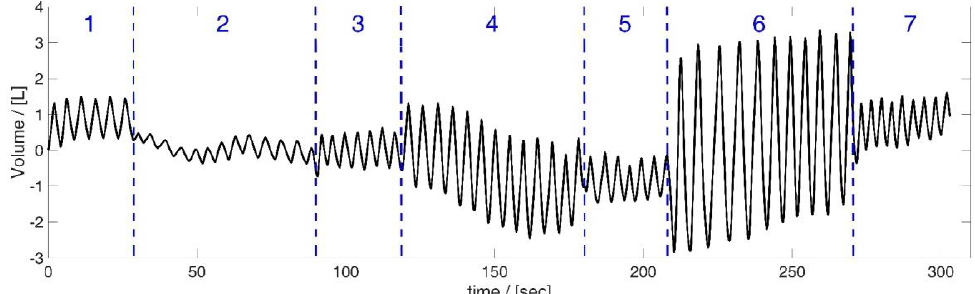
Figure 4. Volume data obtained by the spirometer during the respiratory manoeuvre, illustrated based on the data of subject 5. Manoeuvre: breathing different tidal volumes—periods of shallow (2), medium (4) and maximal breaths (6) between short periods of normal spontaneous breathing ((1), (3), (5) and (7)).